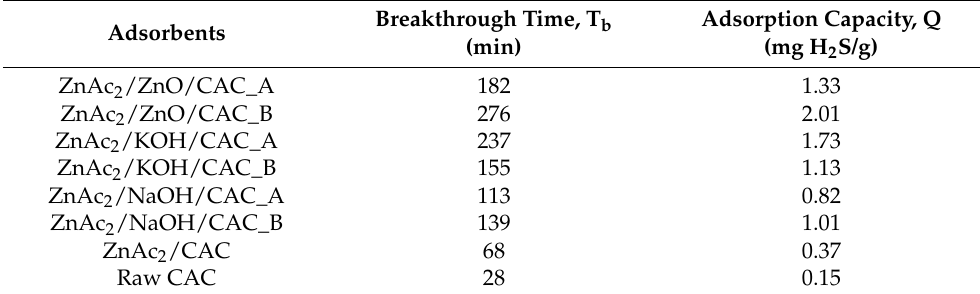
Figure 5. Breakthrough adsorption curve for different BMC adsorbents. Table 3. Adsorption capacity of H 2 S.